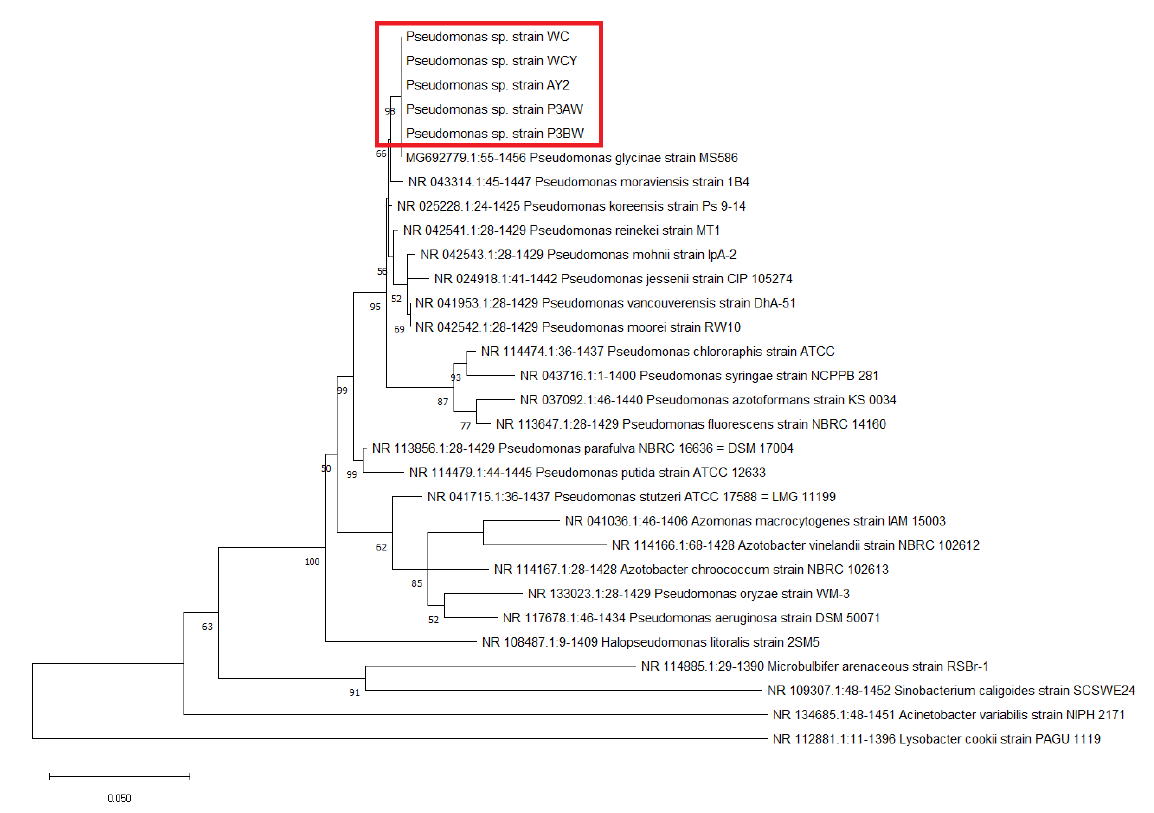
Figure 1. Maximum likelihood phylogenetic tree of Pseudomonas sp. strains based on the 16S rRNA gene. The number at the branches indicates the percentage of occurrences of that branch over 1000 bootstrap replications, with values under 50% hidden. Pseudomonas sp. strains from A. palmeri are circled by the red box.